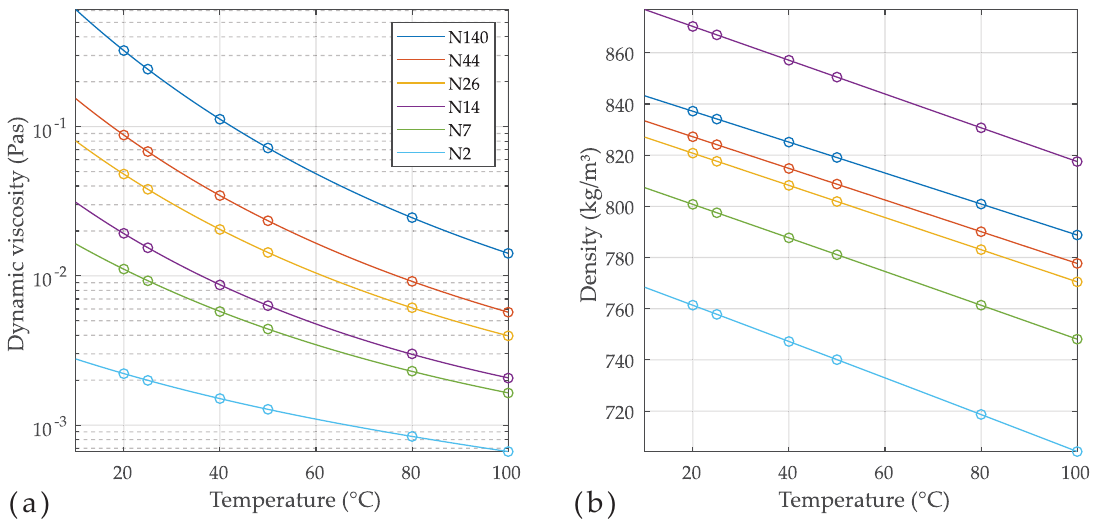
Figure 3. Dynamic viscosities ( a ) and densities ( b ) of various NIST-traceable viscosity reference fluids ( ◦ ). The lines represent temperature models [34]. The numbers of the standards coarsely agree with the kinematic viscosity in cSt at 40 ◦ C, i.e., ν of N14 is approx. 14 cSt at 40 ◦ C.